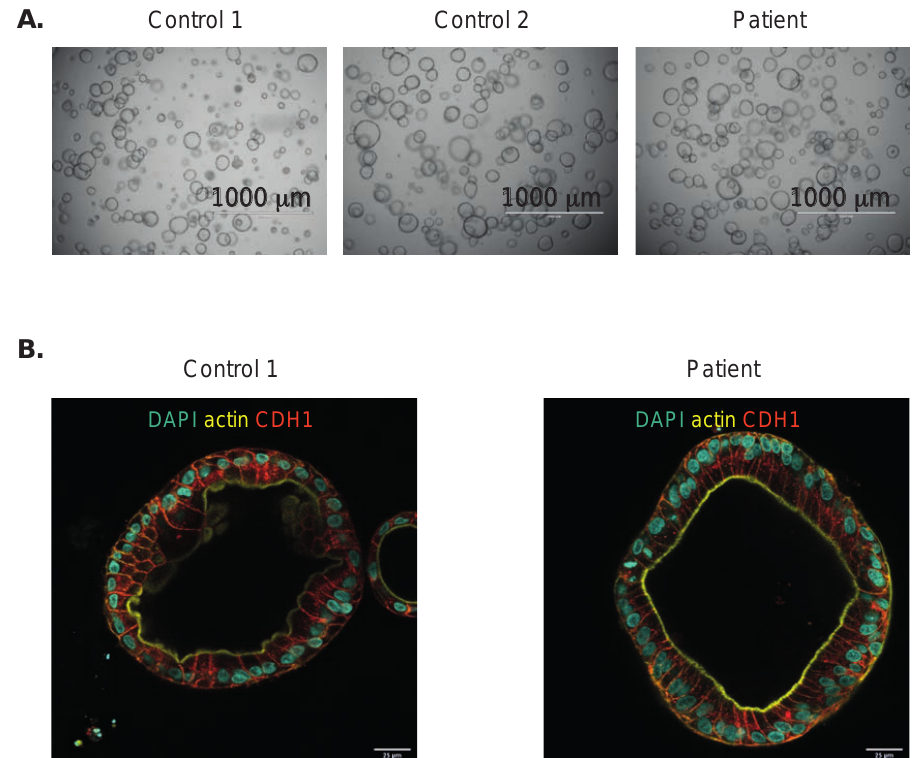
Figure 3. Normal growth and polarization of ANTXR2-deficient organoids. ( A ) Microscopic brightfield images of two controls and Patient 1 organoids grown for 7 days in EM. ( B ) Confocal staining for markers of enterocyte polarization. Actin (yellow) stains the apical membrane, E-cadherin (CDH1, red) stains the basolateral membrane and DAPI (blue) stains the